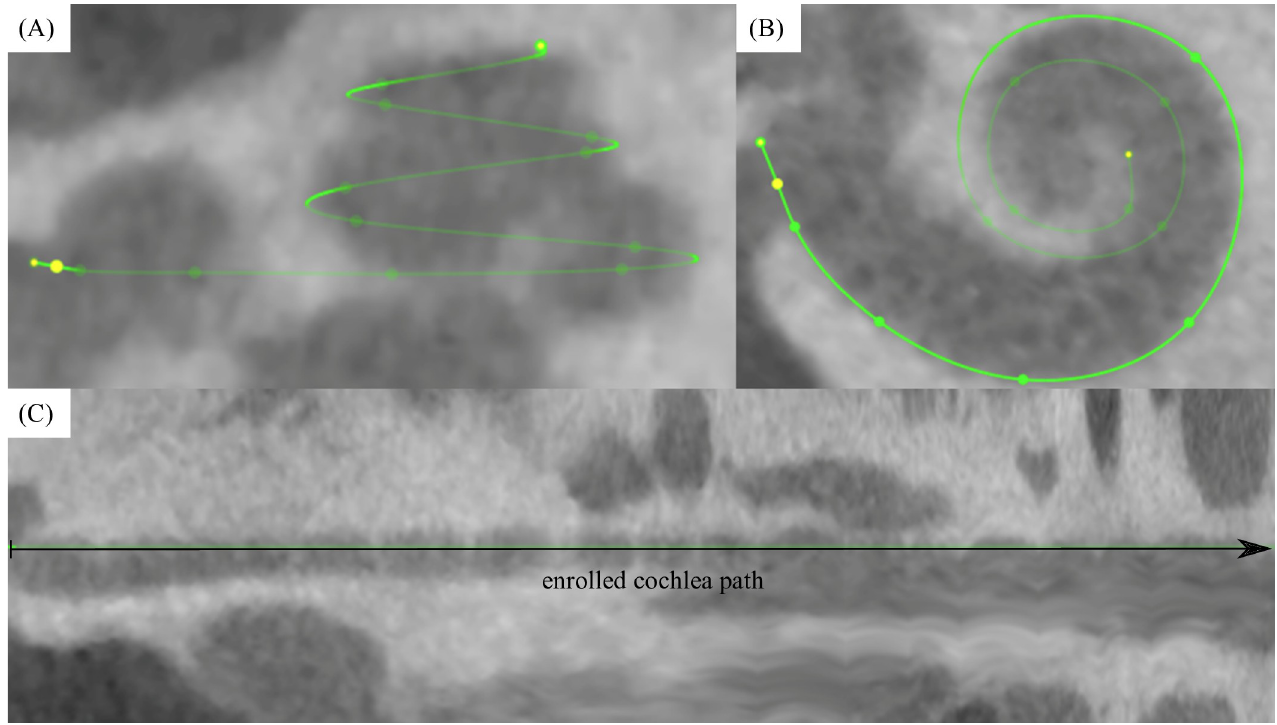
Fig 3. Complete segmentation of the lateral wall. Visualization of a completed lateral wall tracing in OsiriX MD (A, B) with the additional display of the enrolled path (C) for which the length is computed automatically.